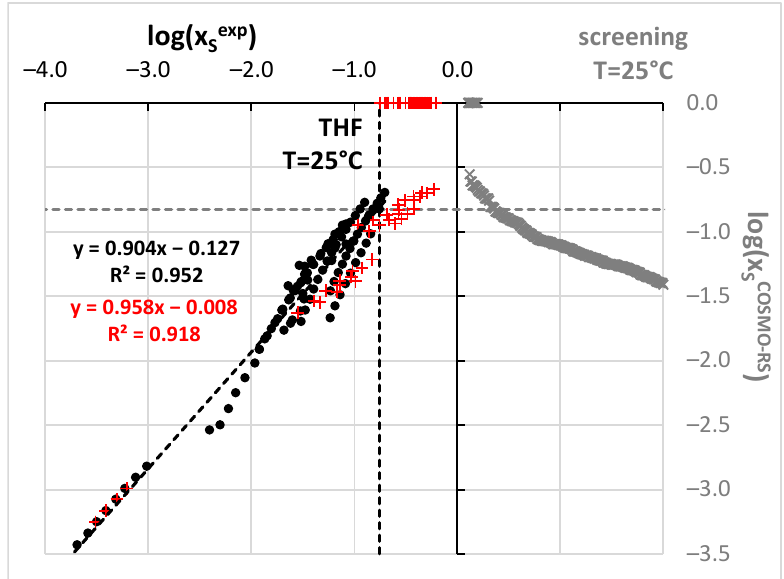
Figure 5. Results of salicylamide solubility measurements and computations. Notation is the same as in Figure 2.